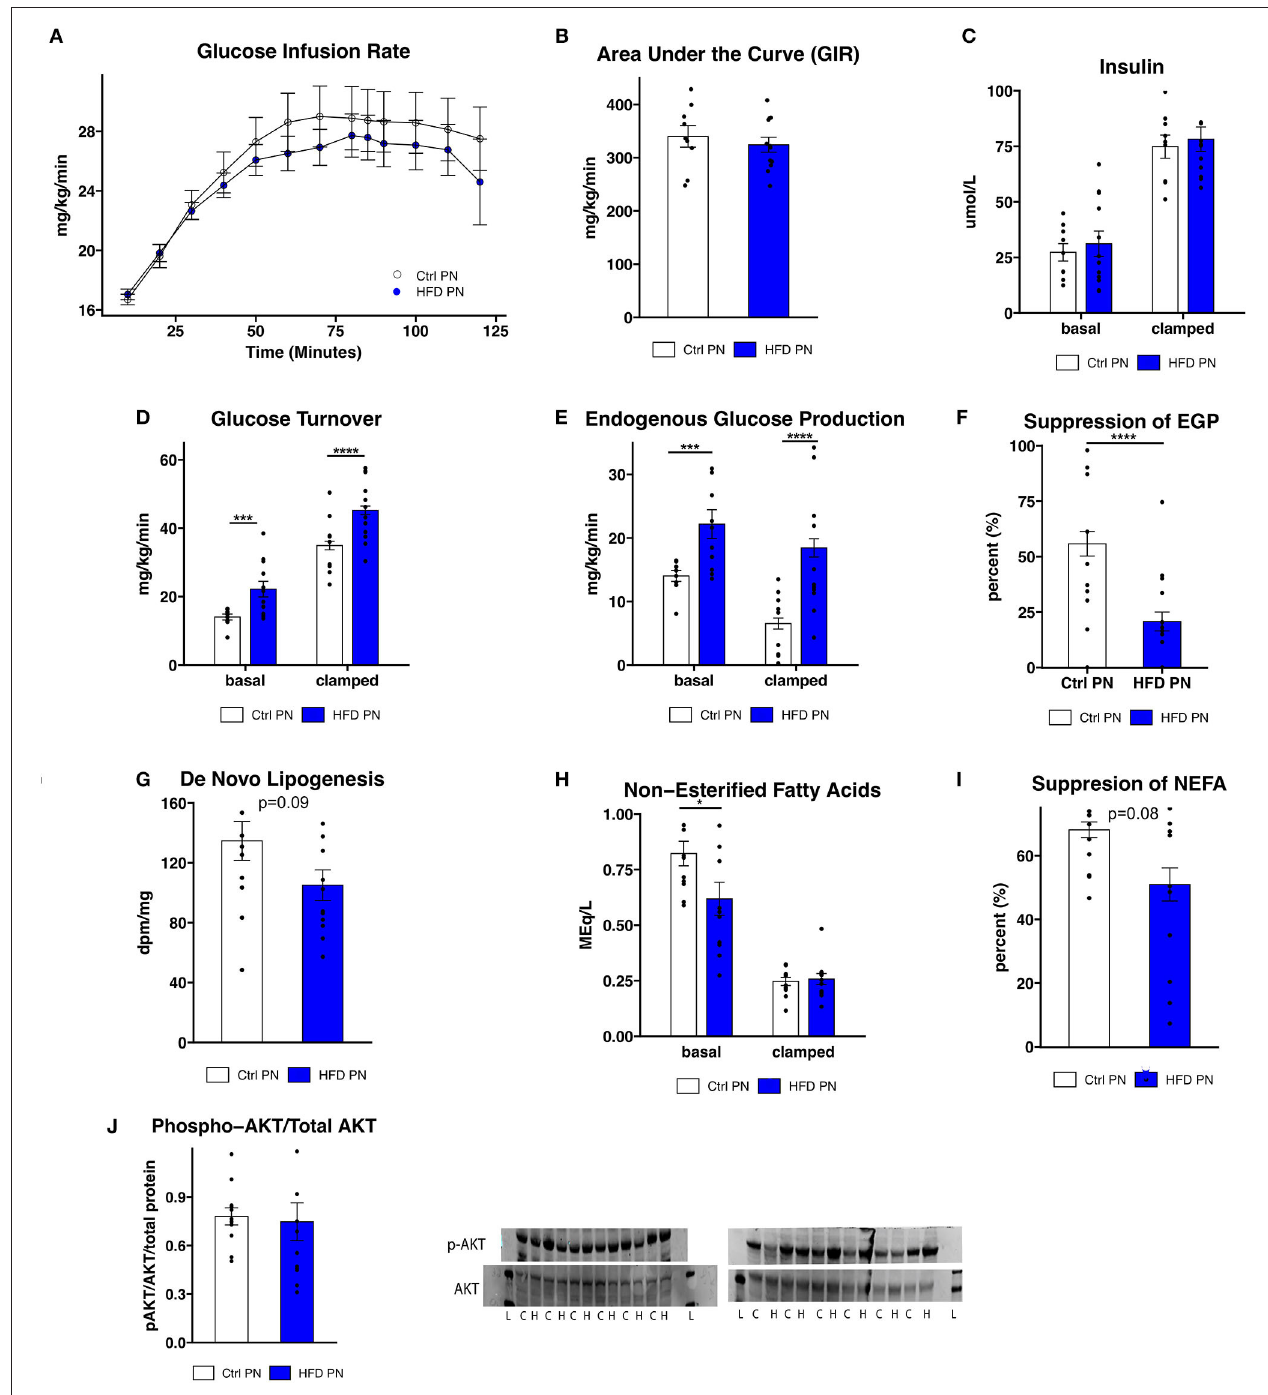
FIGURE 3 | Insulin sensitivity and glucose production. Three-month-old male mice whose mothers either had normal diet (Ctrl PN, n = 9) or high-fat diet (HFD PN, n = 12) during the lactation period underwent a hyperinsulinemic euglycemic clamp, beginning after a 6-h fast. (A) Time course of glucose infusion rate (GIR) over the course of the clamp study. (B) The area under the curve for GIR (C) . Insulin levels at basal and clamped conditions (D) . Glucose turnover at basal and clamped conditions. (E) Endogenous glucose production (EGP) at basal and clamped conditions (F) . Percent suppression of EGP (G) . De novo lipogenesis in liver tissue in response to insulin (H) . Non-esterified fatty acids (NEFA) in serum at basal and clamped conditions (I) . Suppression of NEFA in serum (J) . Western blot of liver tissue showing AKT and p-AKT (ser473) protein levels. Western blot abbreviations: C, Ctrl PN; H, HFD PN; L, Ladder. Other abbreviations: Ctrl, control; HFD, high-fat diet; PN, post-natal. * p < 0.05, *** p < 0.001, **** p < 0.0001.